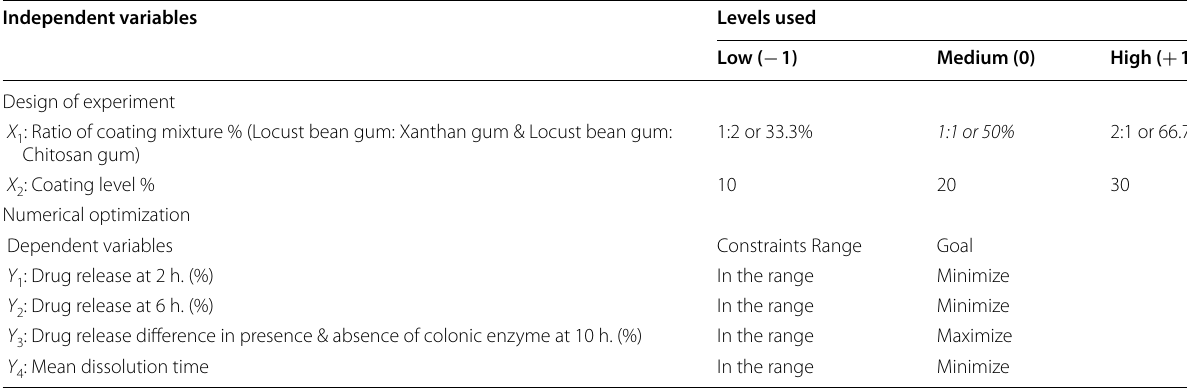
Table 1 Variables of response surface design Independent